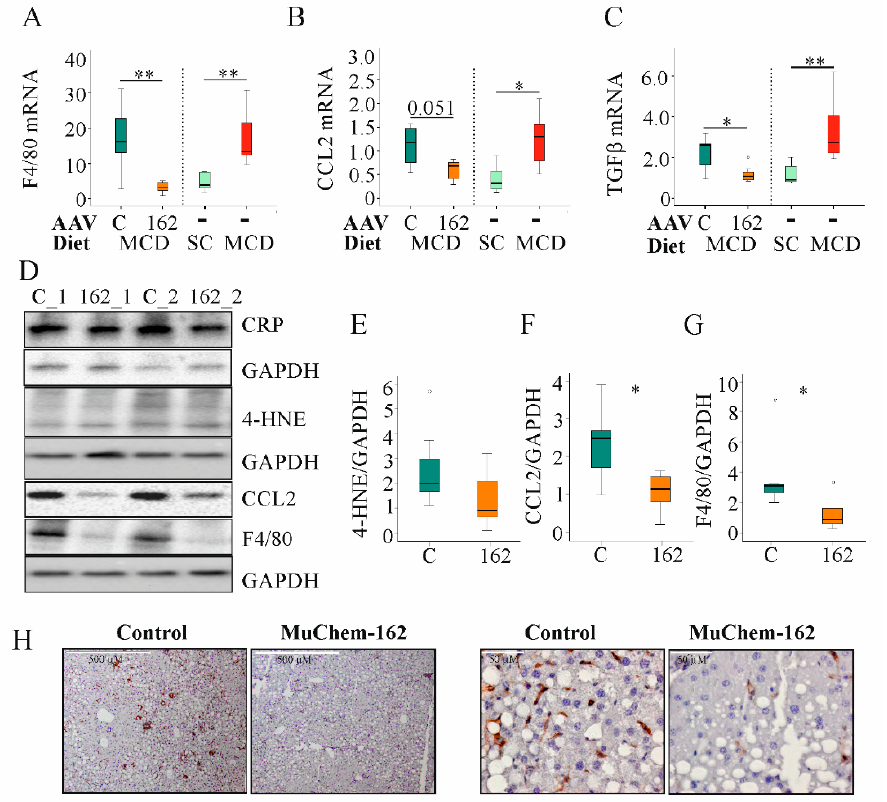
Figure 4. Overexpression of muChem-162 normalized F4/80 , CC-chemokine ligand (CCL)2, and transforming growth factor (TGF) β mRNA levels in the liver of methionine–choline deficient (MCD)- diet-fed mice and reduced 4-hydroxynonenal (4-HNE), CCL2, and F4/80 protein levels: ( A ) F4/80 mRNA in the liver of mice infected with the control AAV8 or muChem-162-producing AAV8 fed an MCD diet. Data for non-infected mice fed standard chow (SC) or an MCD diet are shown in parallel on the right side of the dotted line. ( B ) CCL2 mRNA in the liver of these mice. The number in the figure is the p -value. ( C ) TGF β mRNA in the liver of these mice. ( D ) CRP, 4-HNE, CCL2, and F4/80 protein in the liver of two control-infected mice (i.e., C_1 and C_2) and two muChem-162-expressing mice (i.e., 162_1 and 162_2) fed an MCD diet. ( E ) Quantification of the 4-HNE. ( F ) Quantification of the CCL2 protein. ( G ) Quantification of the F4/80 protein. Protein levels were normalized to glyceraldehyde 3 phosphate dehydrogenase (GAPDH) ( n = 6–7 mice per group). Mann–Whitney U test. ( H ) Immunohistochemistry of F4/80 in the liver. * p < 0.05, ** p < 0.01. Outliers = values between 1.5 and 3 times the interquartile range are shown as circles, and values more than 3 times the interquartile range are shown as stars.